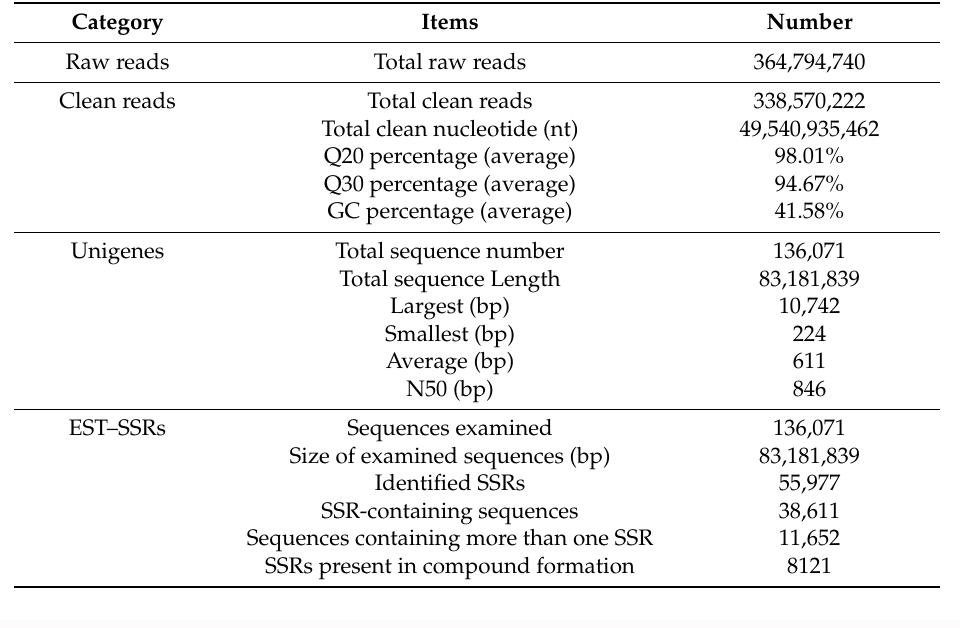
Table 1. Summary of transcriptome sequencing and assembly in Styrax japonicus.